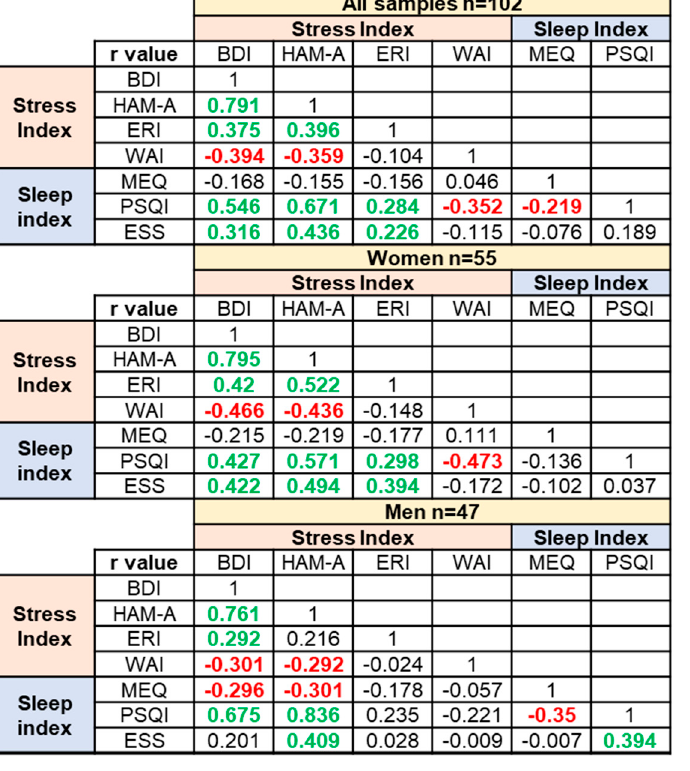
Figure 5. Correlation analyses among all psychodiagnostics questionnaires. Correlation matrix including all samples (top panel), women (middle panel), and men (bottom panel). Four scales relative to work-related stress: Beck Depression Inventory (BDI), Hamilton Anxiety Scale (HAM-A), Effort Reward Imbalance (ERI), and Work Ability Index (WAI). Three scales relative to work-related sleep quality: Morning Evening Questionnaire (MEQ), Pittsburgh Sleep Quality Index (PSQI), and Epworth Sleepiness Scale (ESS). Green r values indicate positive correlation, and red r values indicate negative correlation.